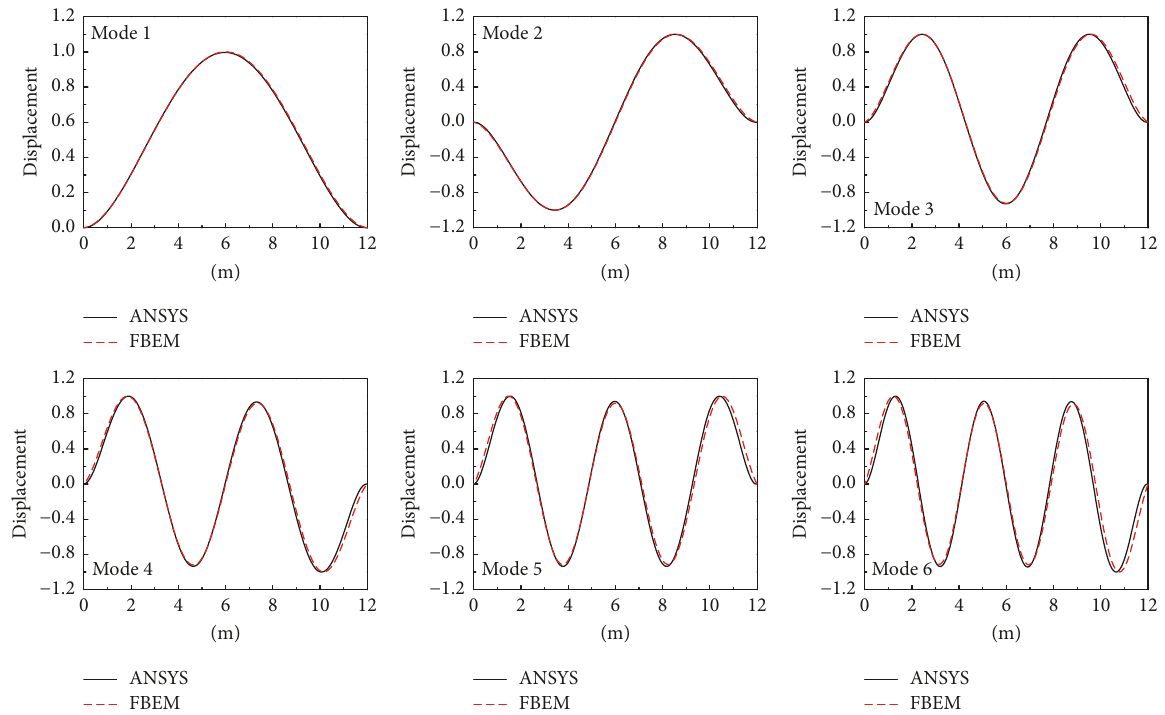
Figure 7: Comparison between the first six flexural modes of ANSYS and FBEM models of